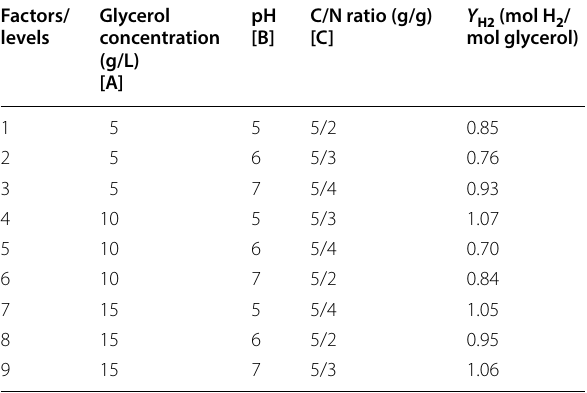
Table 6 The results of orthogonal test for glycerol concentration, pH, and C/N ratio